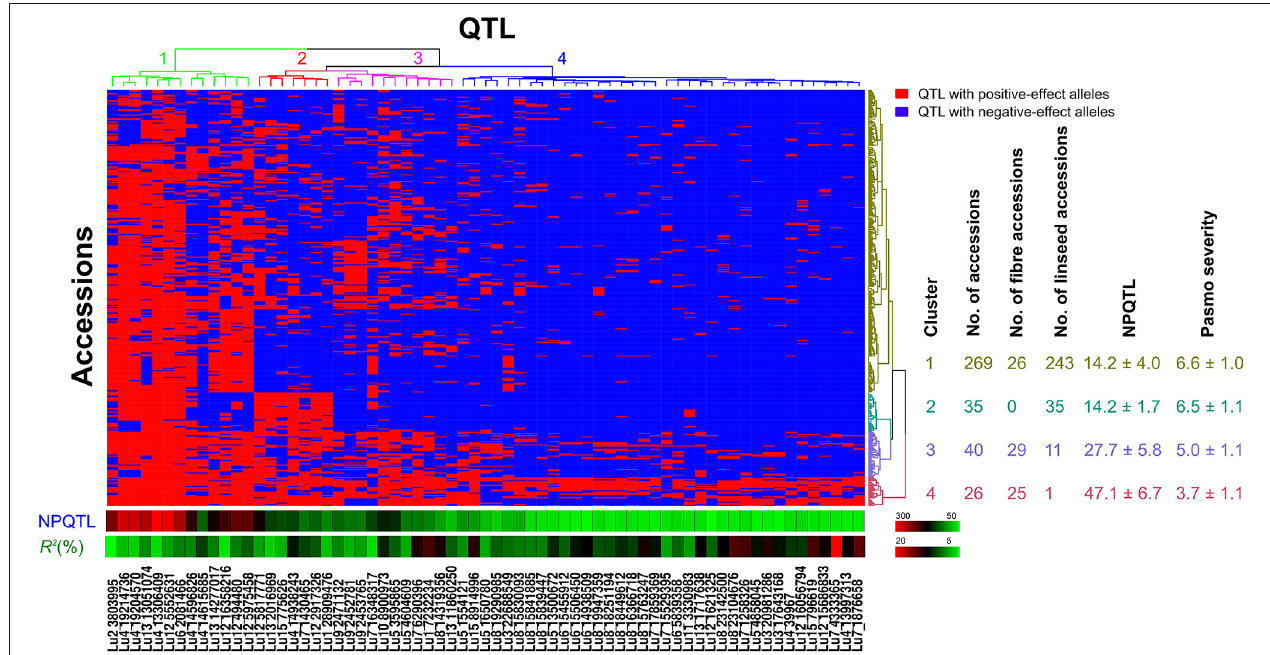
FIGURE 6 | Cluster analysis of the association panel based on a set of 67 stable large-effect QTL. The accessions were grouped into four clusters and the QTL were assigned to four sub-groups. Tag QTNs of QTL were chosen for analysis. QTL with positive-effect alleles (PQTL) in the accessions are indicated in red; blue indicates the absence of PQTL. NPQTL, the number of QTL with positive-effect alleles.